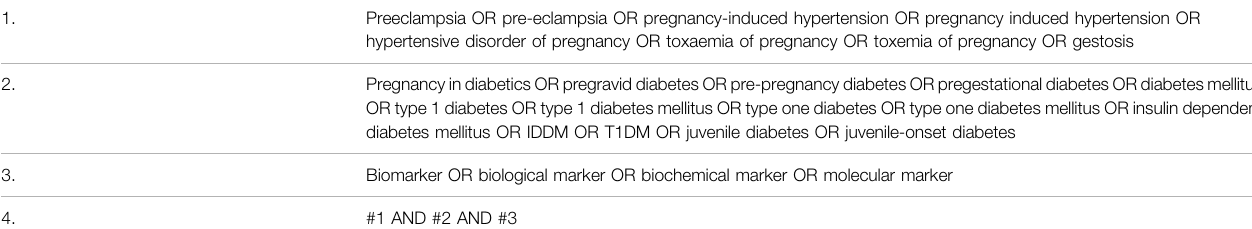
TABLE 1 | Syntax used for searching electronic databases.